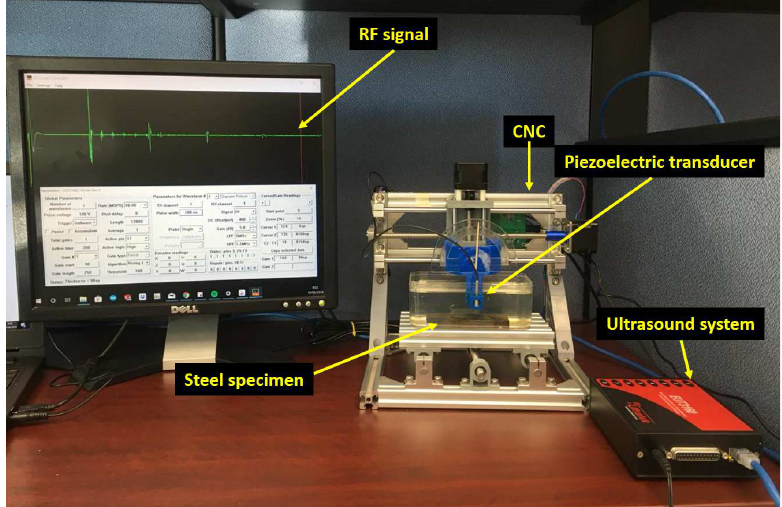
Figure 3. Experimental setup to study the behavior of the ultrasound beam for the determination of the effects of the β angle and the d SO distance between the transducer and the steel